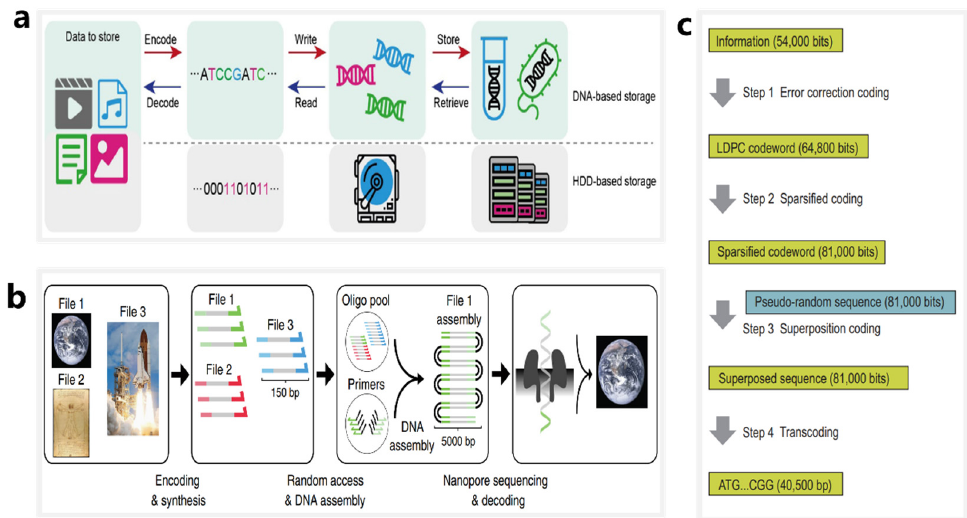
Figure 2. The workflows of DNA storage systems based on synthetic nucleotide sequences. ( a ) The major steps of digital data storage in DNA corresponding to conventional hard-disk storage. Repro- duced with permission from Yaya Hao, SMALL STRUCTURES; published by John Wiley and Sons, 2020. ( b ) An overview of a DNA data storage workflow using ONT nanopores as tools to sequence long double-stranded DNA strands obtained by random access. Reprinted from [101]. ( c ) The work- flow of an in vivo DNA storage system using an artificial yeast chromosome. Reprinted from [22].